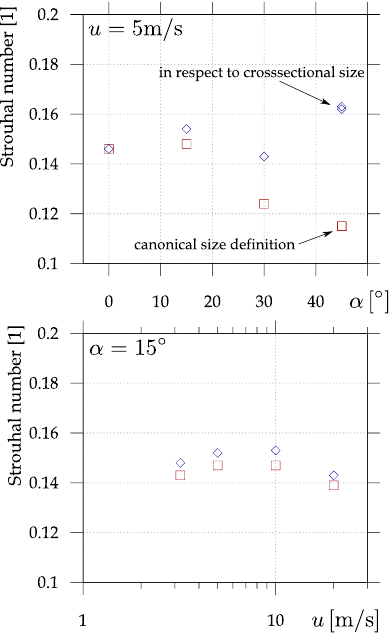
Fig. 8. Top : dependence of the Strouhal number Sr on the angle of attack α at constant imposed stream-wise velocity u = 5m / s. Bottom : Strouhal number as a function of imposed stream-wise velocity u at constant angle of attack α = 15 ◦ . Red squares repre- sent the „standard“ definition with the obstacle size as the charac- teristic length-scale, while blue diamonds use the crosssectional size of the obstacle, i.e. a ′ = a / cos α , where a = 45mm is the side of the studied aluminum